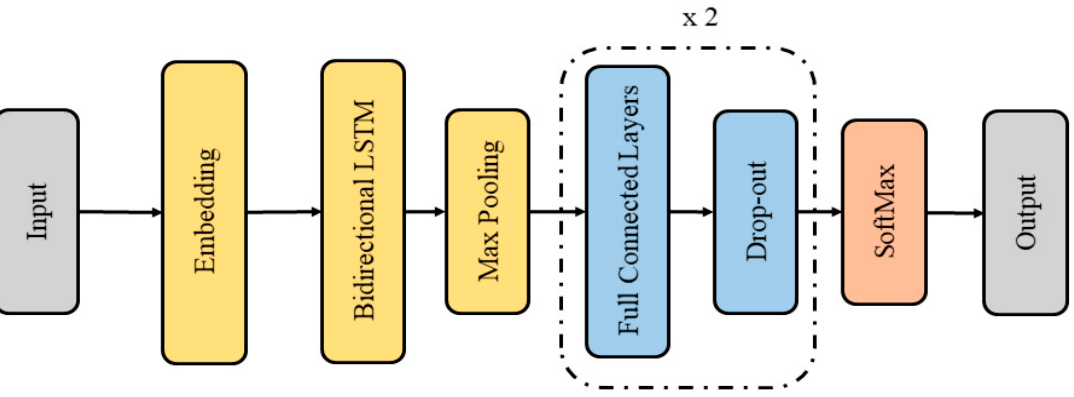
Figure 7. Architecture of CASE using Bi-LSTM and the Max-Pooling